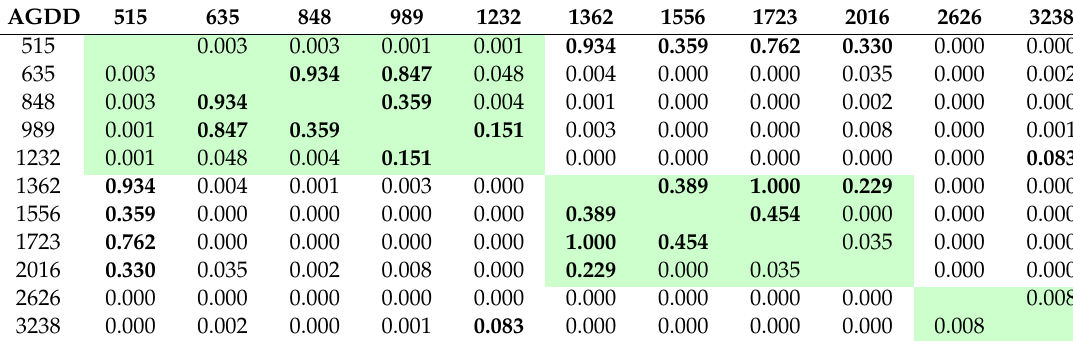
Table A3. p -values of significance test ( p < 0.05) for all observation dates of the RGB setting. Not significant di ff erences are marked in bold. The green color depicts the three temporal windows (i.e., early, medium and late) over the growing season. AGDD